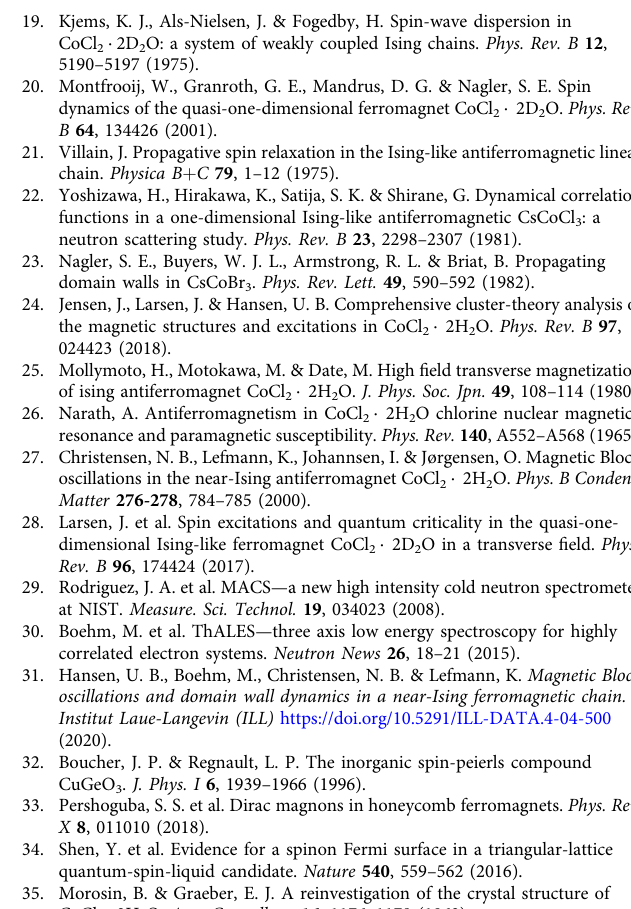
, equation (7) which contains no free (cid:4) (cid:4) (cid:5) B (cid:4) ! λ l ¼ 1